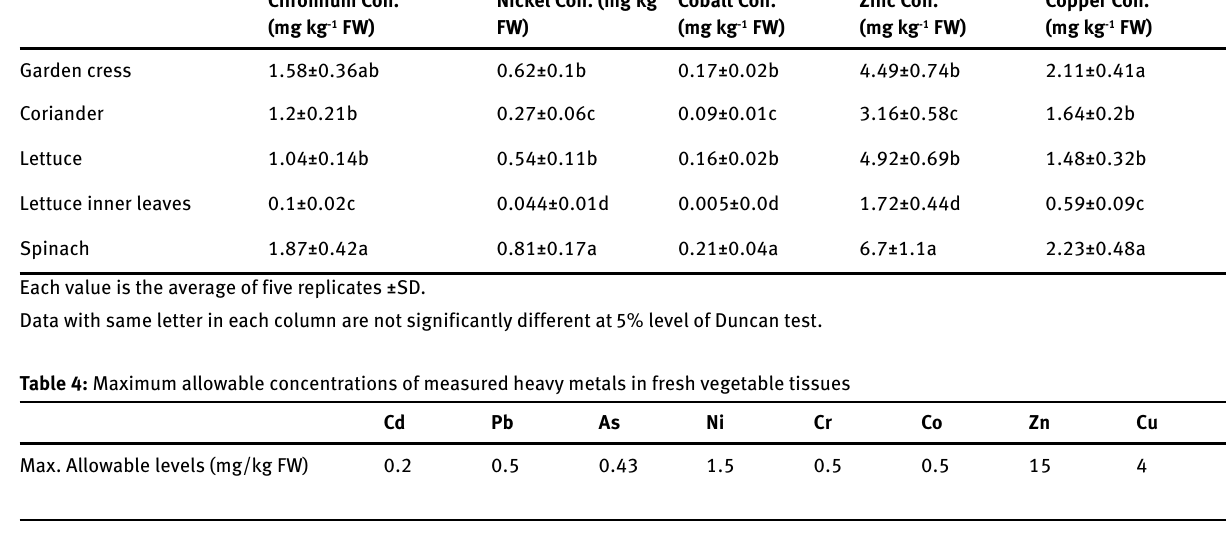
Table 3: Concentrations of chromium, nickel, cobalt, zinc and copper in foliages of different vegetable crops irrigated using waste water Chromium Con.